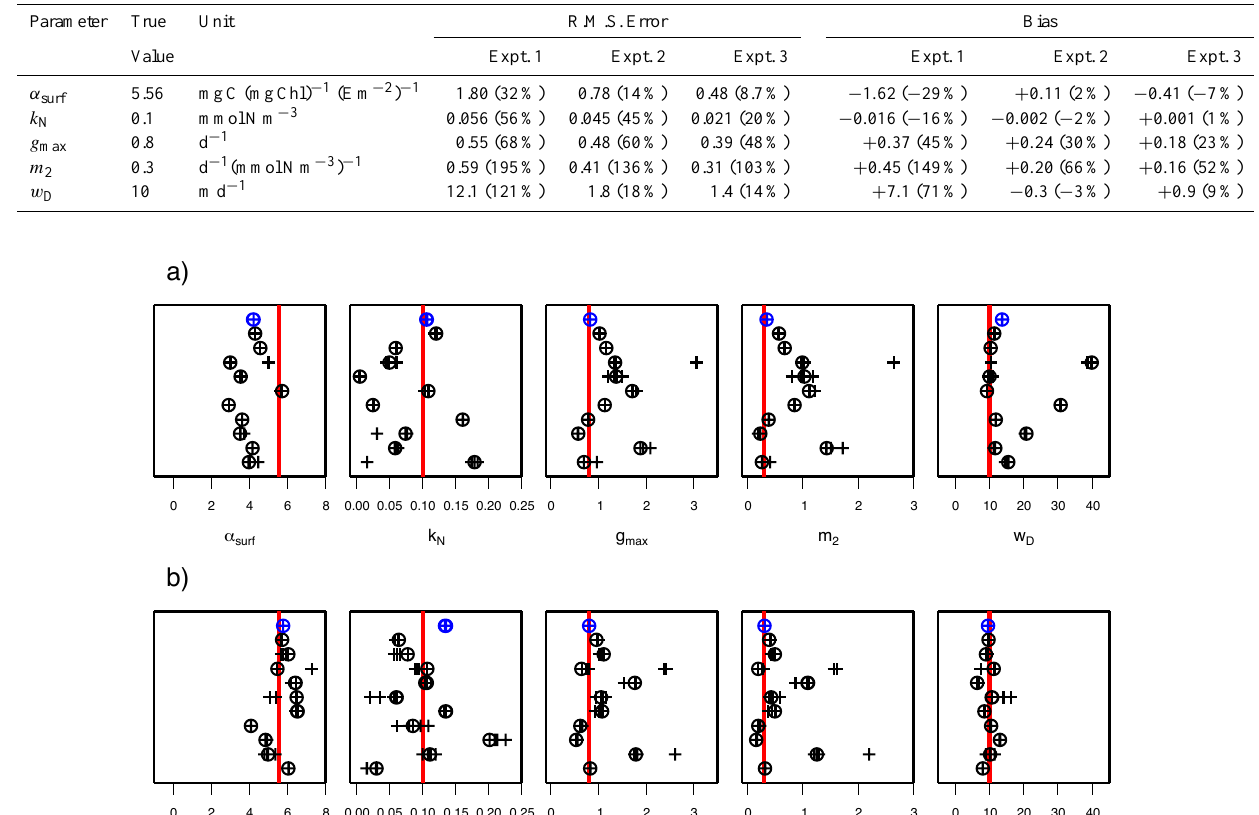
Table 5. Posterior parameter errors.